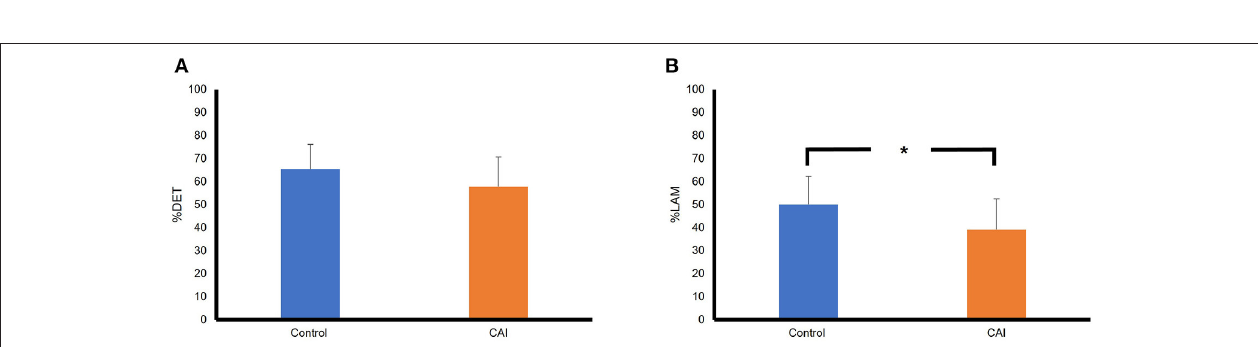
FIGURE 4 | Comparisons of RQA variables between the CAI and control groups in the frontal plane: (A) A comparison of percent determinism (%DET); (B) A comparison of percent laminarity (%LAM). The error bar represents the standard deviation. * p < 0.05. RQA, recurrence quantification analysis; CAI, chronic ankle instability.